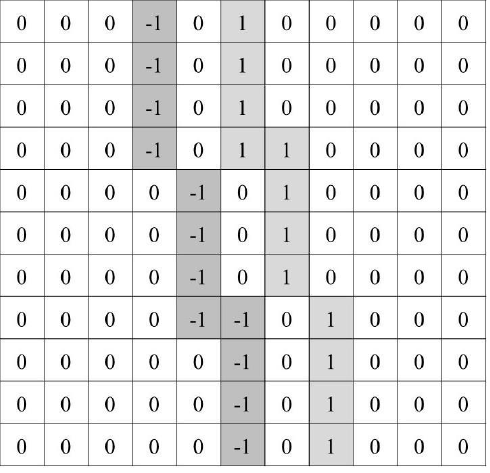
Figure 8. An excerpt from the modified Prewitt operator.